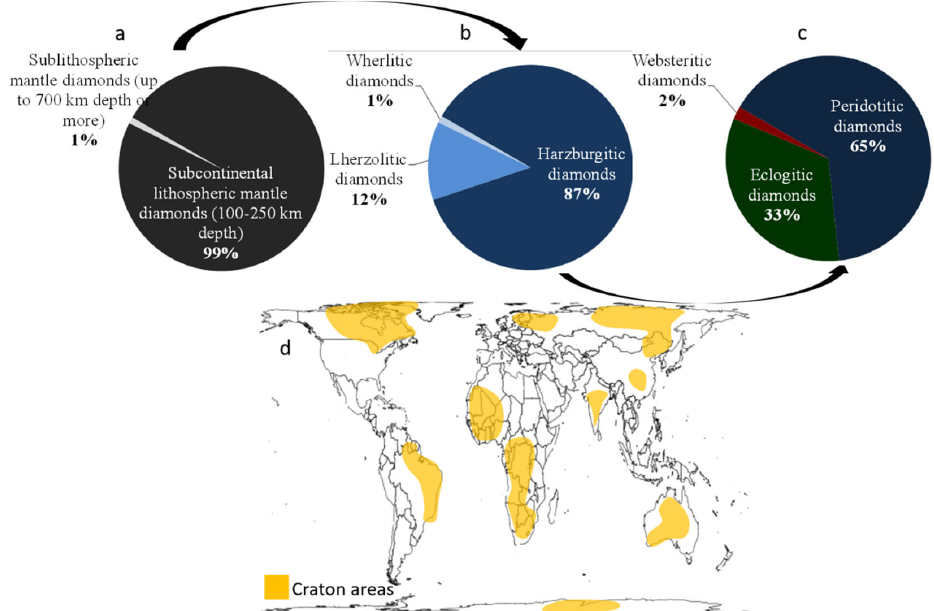
Figure 2. Main geological settings for the formation of natural diamonds. ( a ) Different setting as a function of depth of formation. ( b ) Geological settings for the lithospheric mantle diamonds. ( c ) Parageneses observed for the most common peridotitic diamonds. ( d ) World map for the localization of the main cratons on Earth. These cratons are the main diamond deposits.